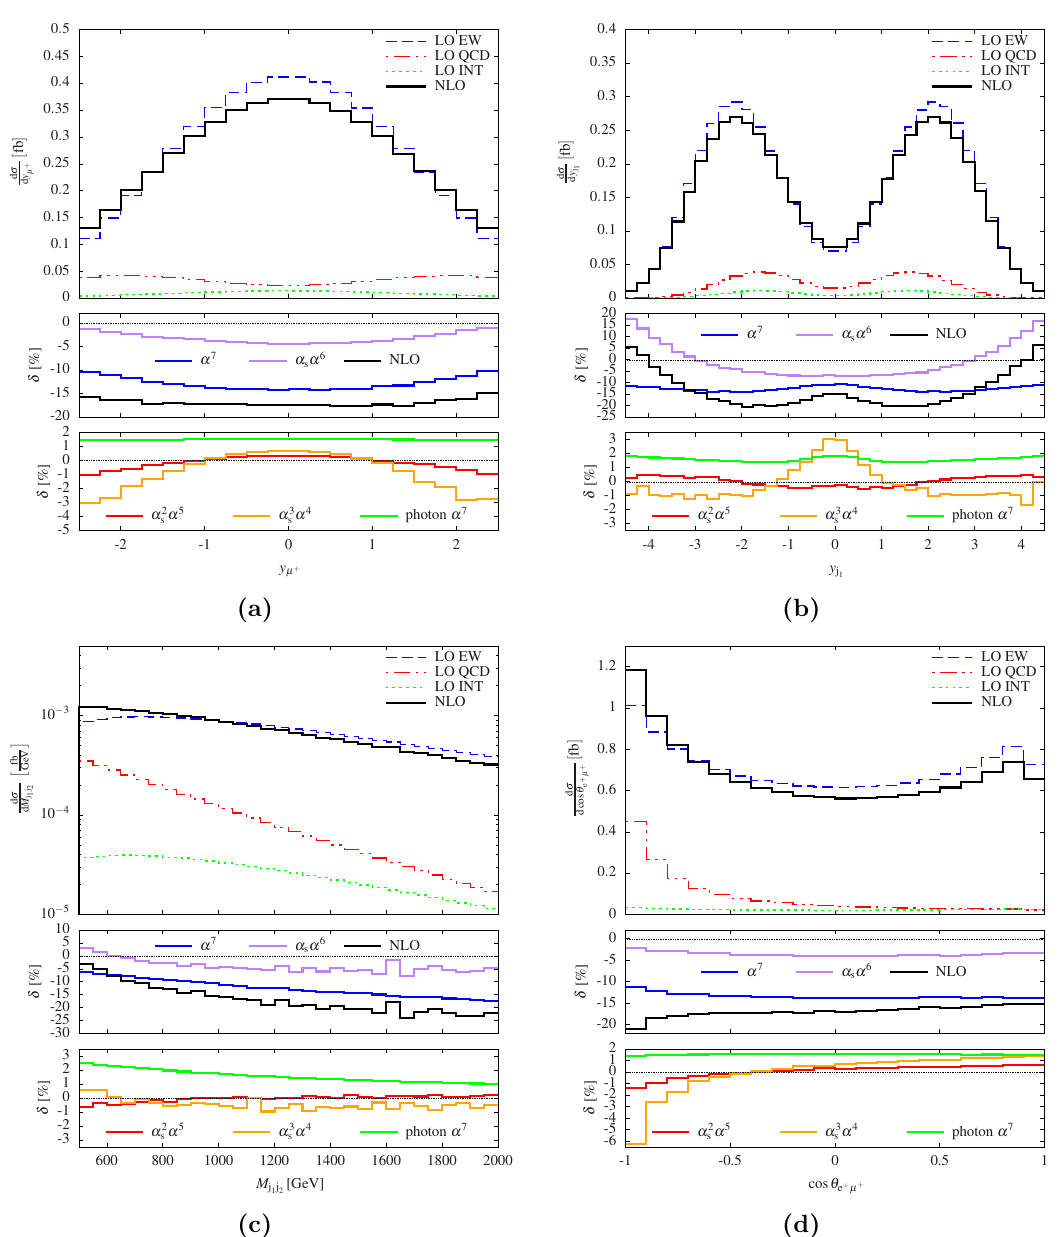
Figure 6. Di(cid:11)erential distributions at a centre-of-mass energy p s = 13 TeV at the LHC for pp (cid:22) + (cid:23) (cid:22) e + (cid:23) e jj: (a) rapidity for the anti-muon (top left), (b) rapidity for the hardest jet (top ! right), (c) invariant mass for the two leading jets (bottom left), and (d) cosine of the angle be- tween the positron and the anti-muon (bottom right). The upper panels show the three LO contributions as well as the sum of all NLO predictions. The two lower panels show the rela- tive NLO corrections with respect to the full LO in per cent, de(cid:12)ned as (cid:14) i = (cid:14)(cid:27) i = . In addition, the NLO photon-induced contributions of P computed with LUXqed is provided separately.